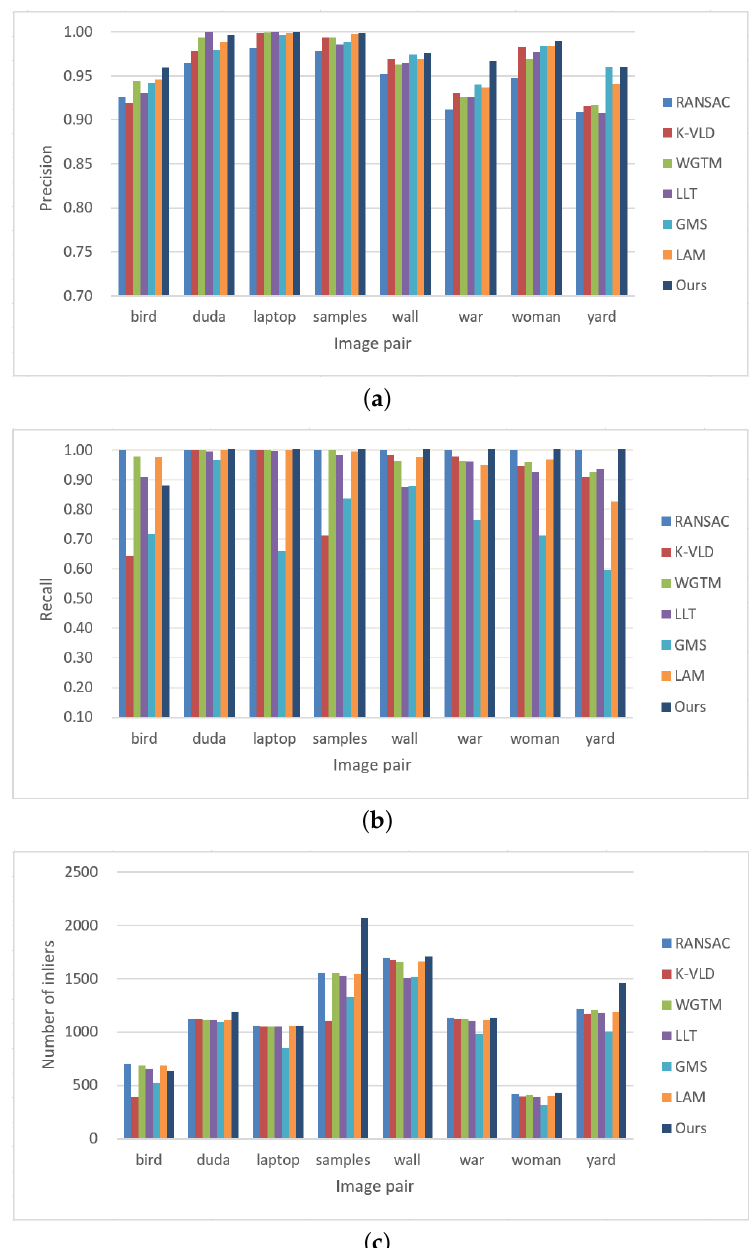
Figure 13. Statistical results for the rigid dataset (dataset 2): ( a ) precision; ( b ) recall; ( c ) number of